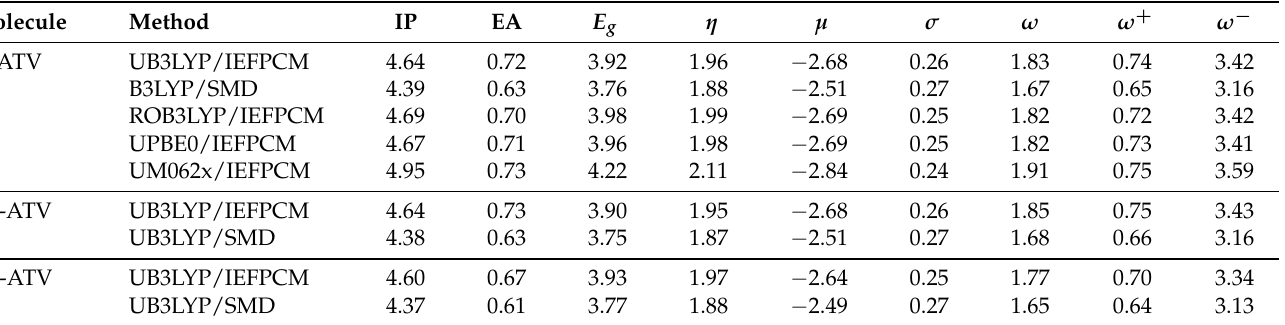
Table 2. Global chemical reactivity indices (eV) for ATV in methanol computed using 6-31+G(d,p) ba- sis sets and the exchange-correlation functionals (B3LYP, PBE0, M062x) and solvent models (IEFPCM, SMD) specified